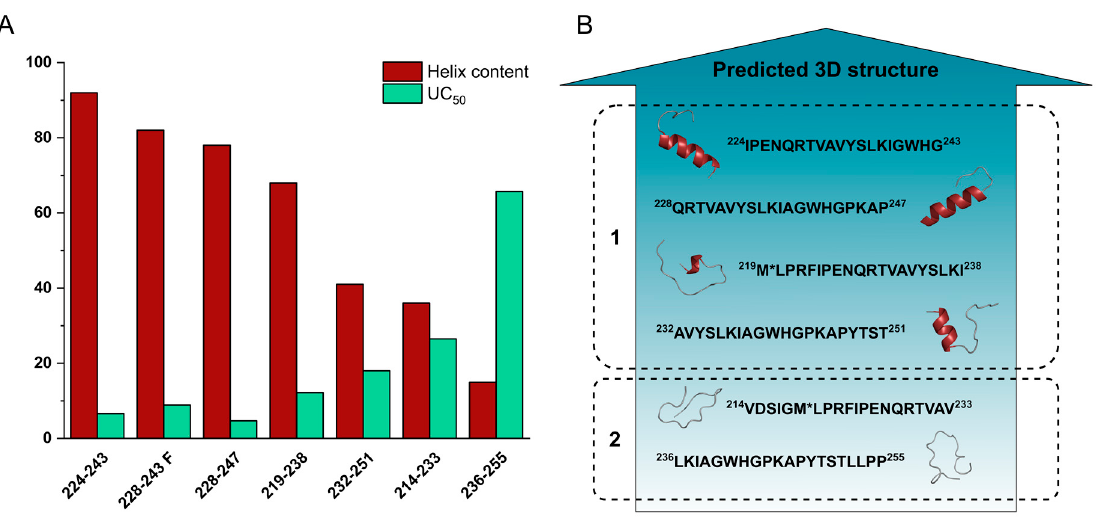
Figure 8. ( A ) Comparison of the helix content in TFE solution of acetylated HSV peptides based on ECD; calculated with the formula of Chen and Yang [32] (Table 2) with their respective UC 50 values of Cf-peptides, data were obtained from cellular uptake studies (Table 1). ( B ) PEP-FOLD3 predicted secondary structure of HSV peptides (Figures S14 and S15), the prediction method refers structures in mostly aqueous solutions [21,37].